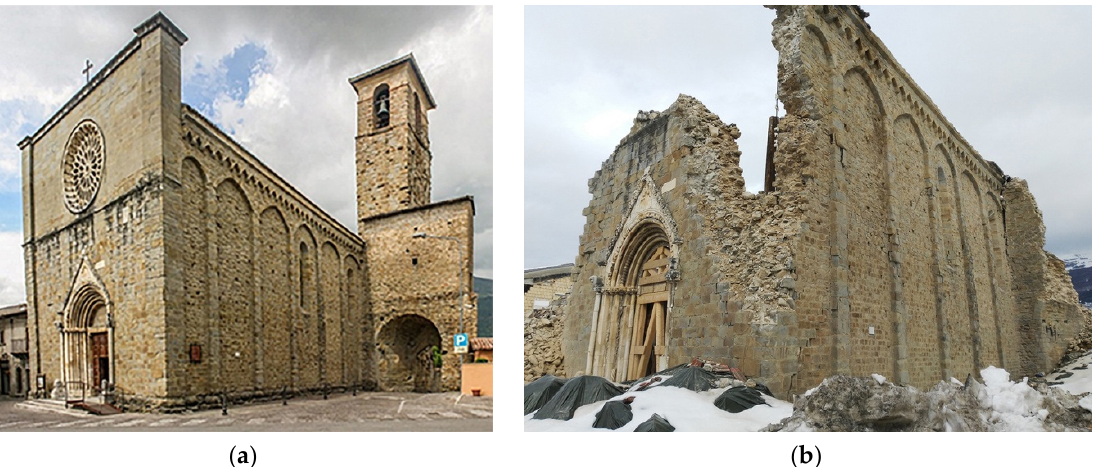
Figure 1. St. Agostino church in Amatrice before ( a ) and after ( b ) the seismic earthquake swarm of 2016 in Central